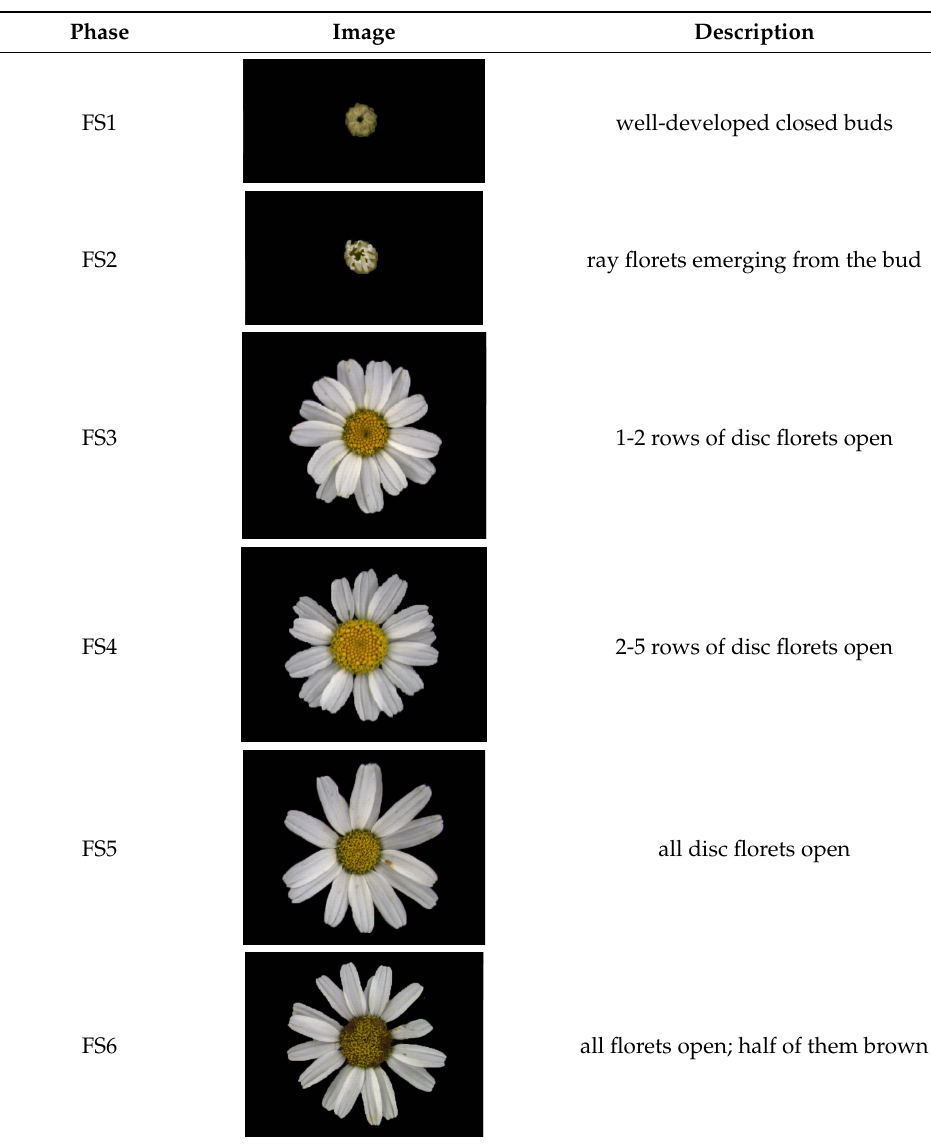
Table 2. Flower developmental stages of Dalmatian pyrethrum.